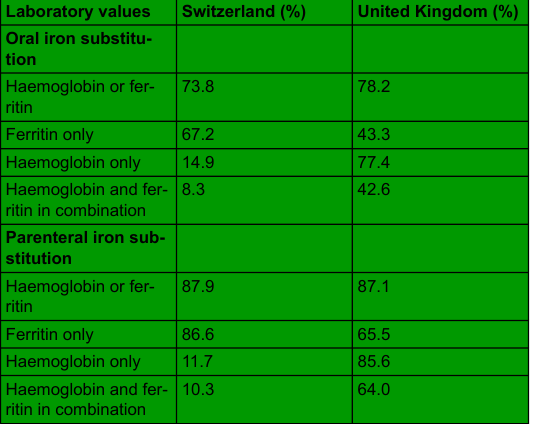
Table 3: Laboratory parameters (ferritin, haemoglobin) measured with- in 180 days before iron substitution (percentage of patients treated). Laboratory